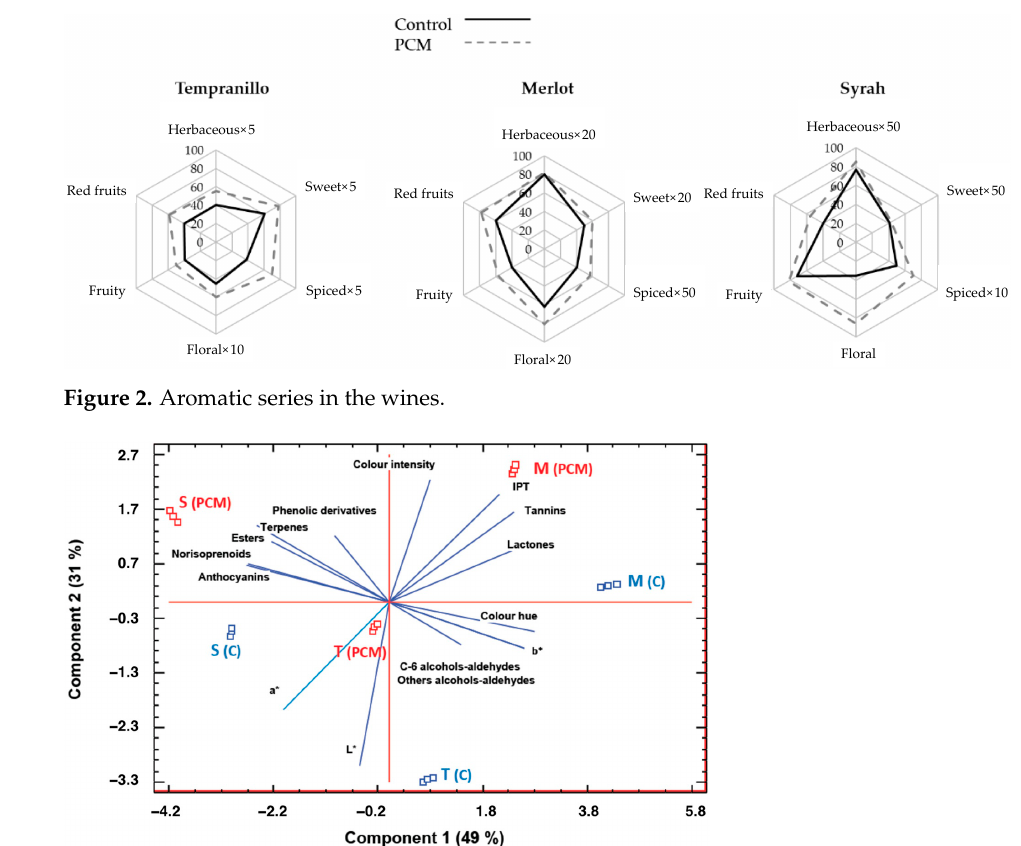
Figure 4. Evolution of phenolic compounds and color characteristics with aging time in bottle. ( A ) Phenolic compounds and ( B ) Color properties.